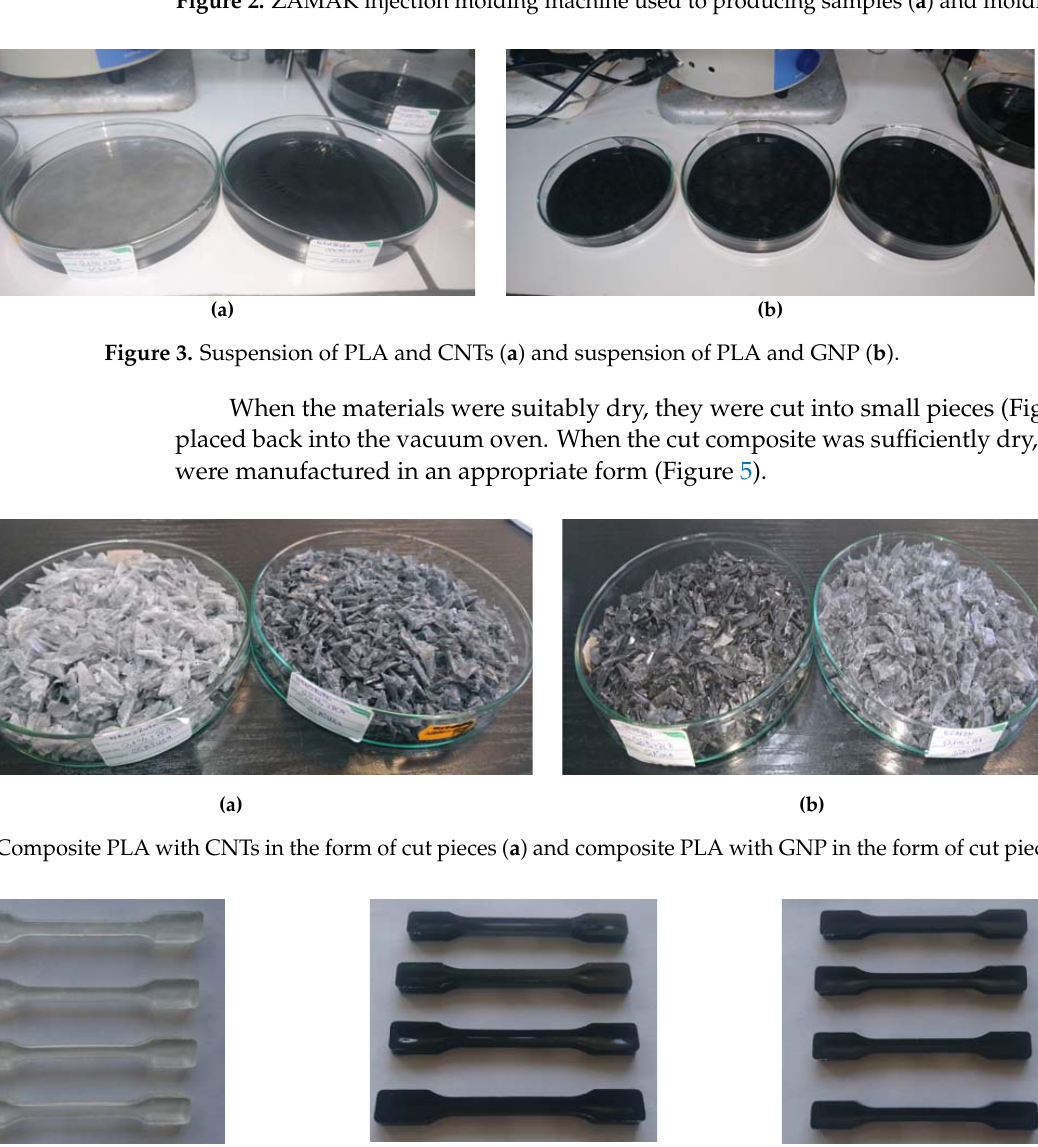
Figure 5. Samples made of pure PLA 4032D ( a ), PLA with the addition of 0.1% and 0.5% of CNTs ( b ) and PLA with the addition of GNP ( c ).